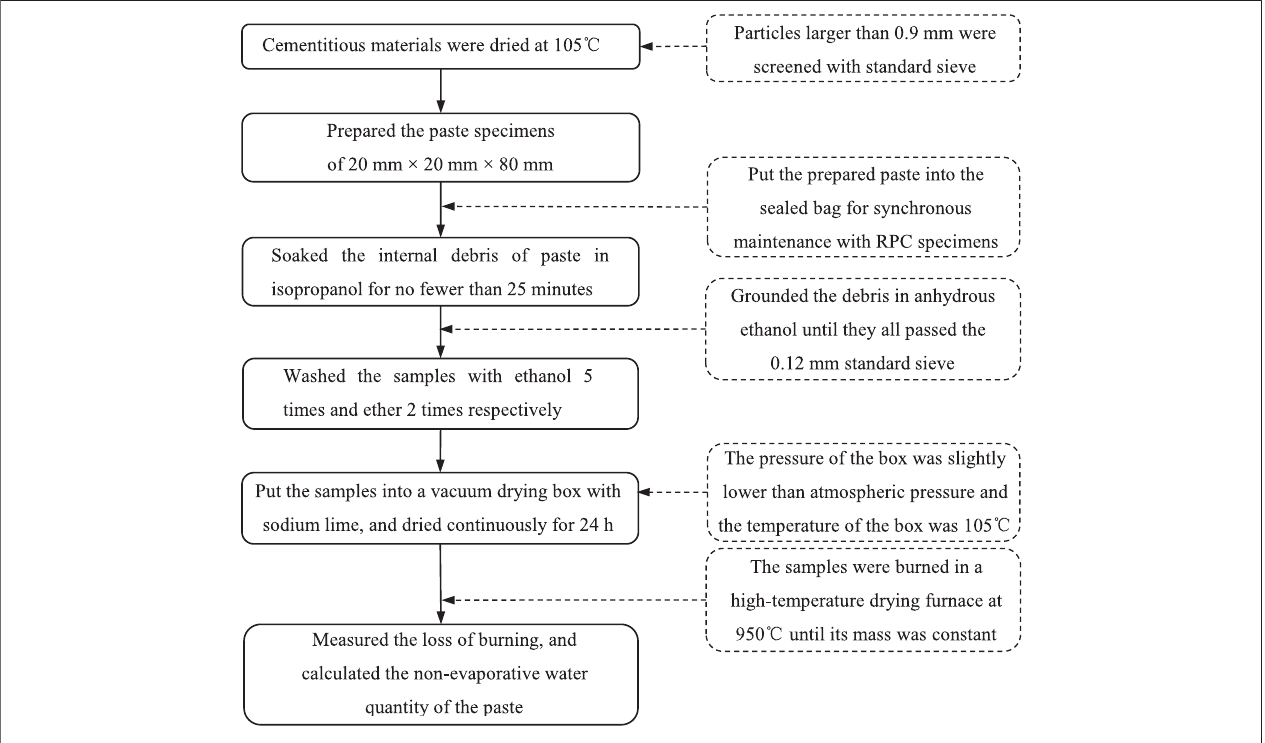
Figure 2 | Schematic diagram of non-evaporated water volume test.